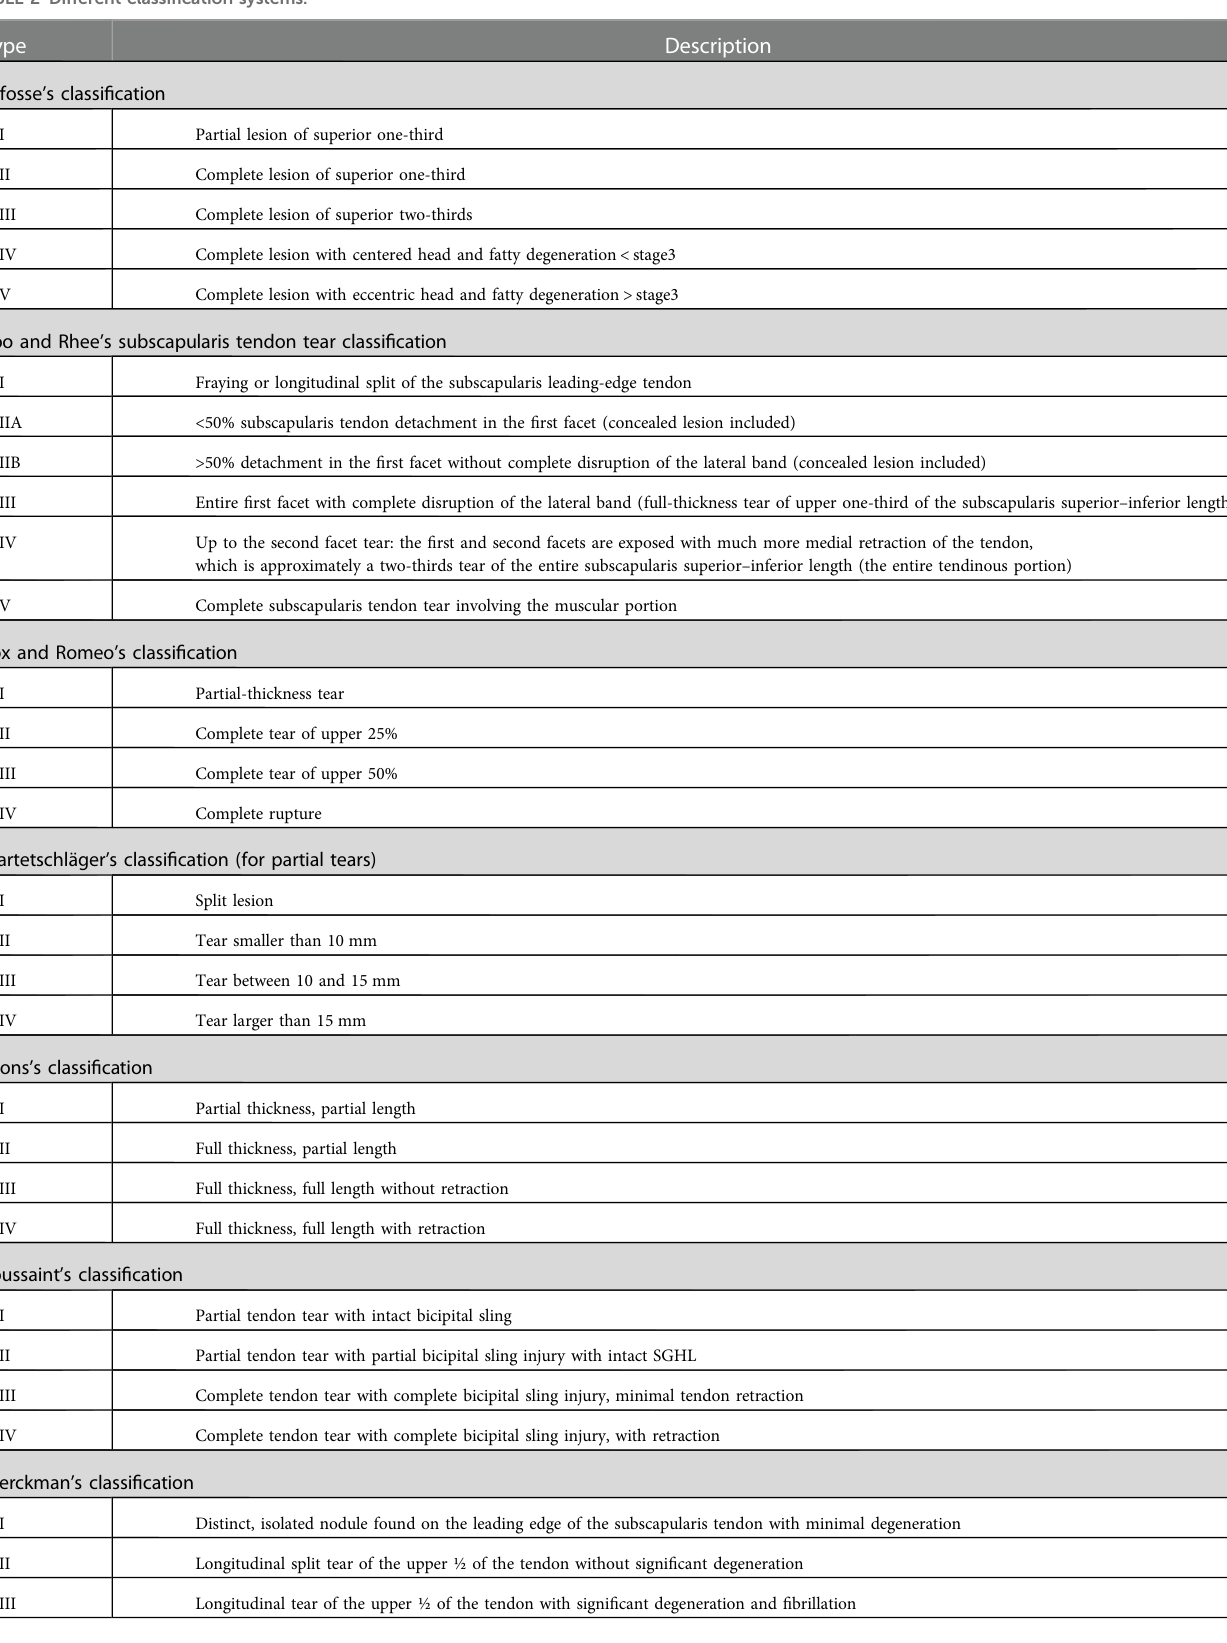
TABLE 2 Different classi fi cation